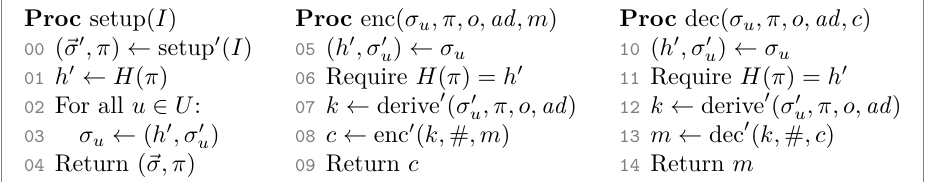
Figure 13: Our alternative RWES construction with procedures setup , enc , dec using procedures setup 0 , derive 0 of a generic KAS kas, procedures enc 0 , dec 0 of a generic AEAD scheme aead, and a collision-resistant hash function H . In [08,13] we write # for any fixed associated-data string; in particular this can be the empty string. If the conditions in [06,11] are not fulfilled, the respective algorithm